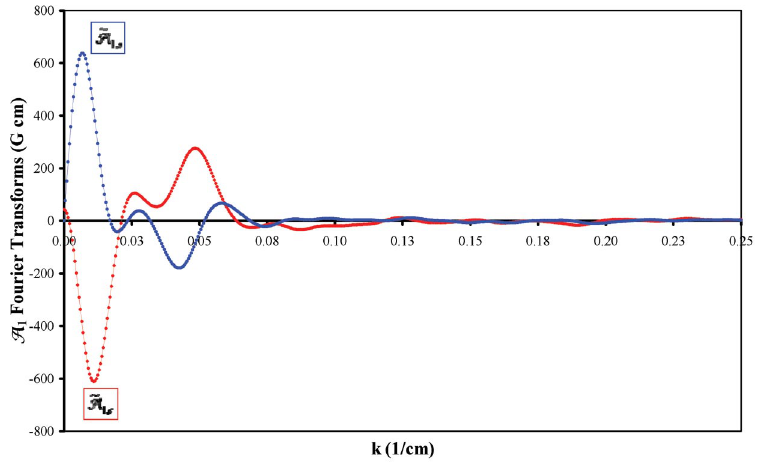
(cid:4) R; k (cid:5) versus k 1 ;(cid:4)